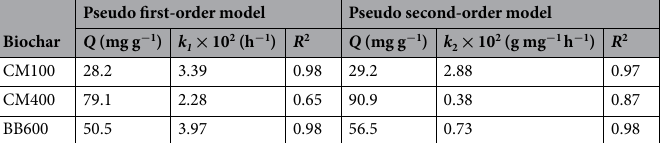
Table 3. Parameters of pseudo first- and second-order kinetic models for Pb adsorption by the cattle manure biochar (CM100 and CM400) and bamboo biochar (BB600). The numbers in the sample names represent the pyrolysis